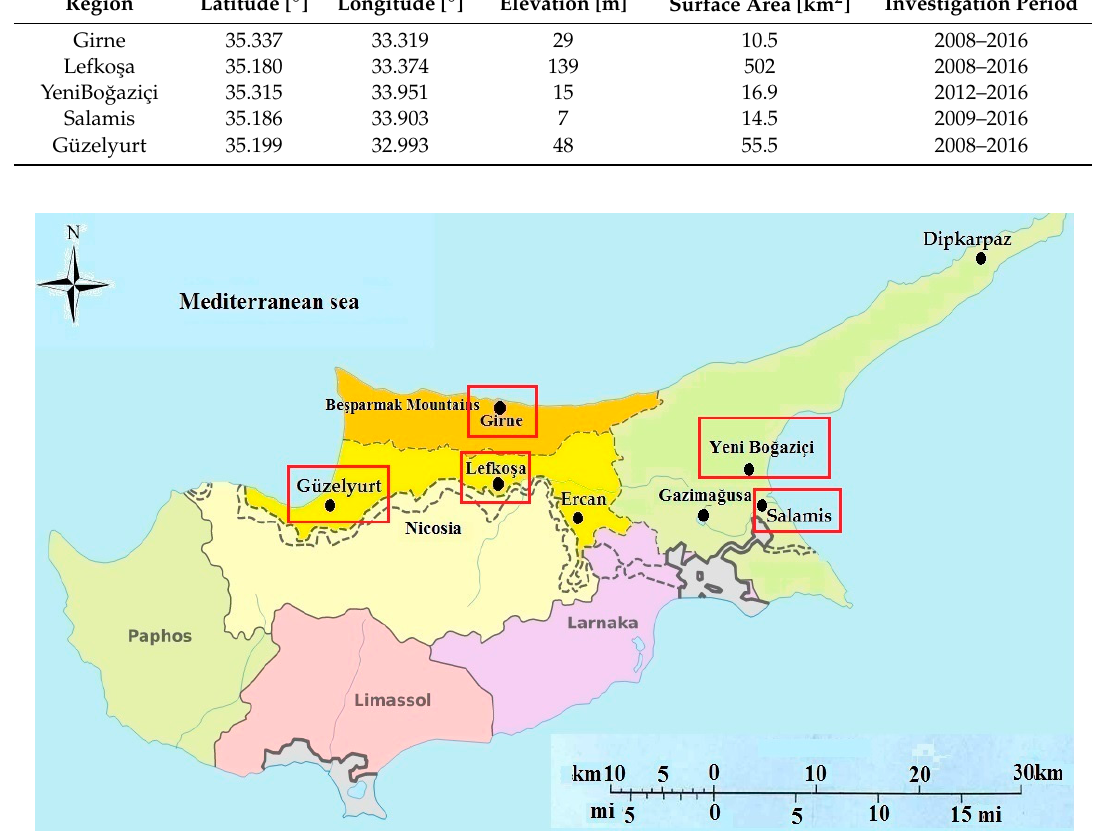
Figure 4. Map of Cyprus.